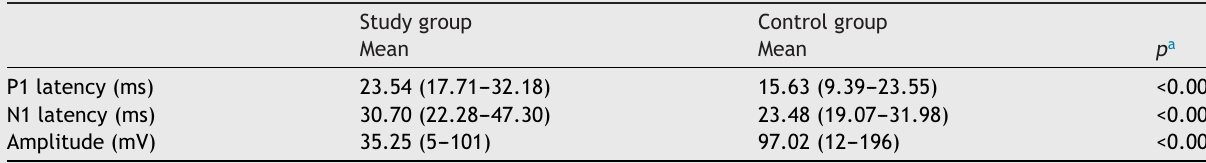
Mean values of latencies and amplitudes in study and control